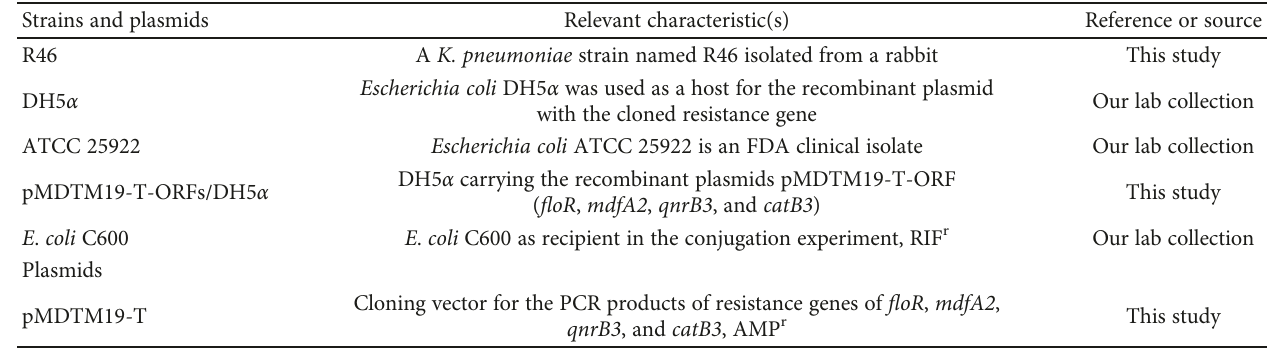
Table 2: Strains and plasmids used in this